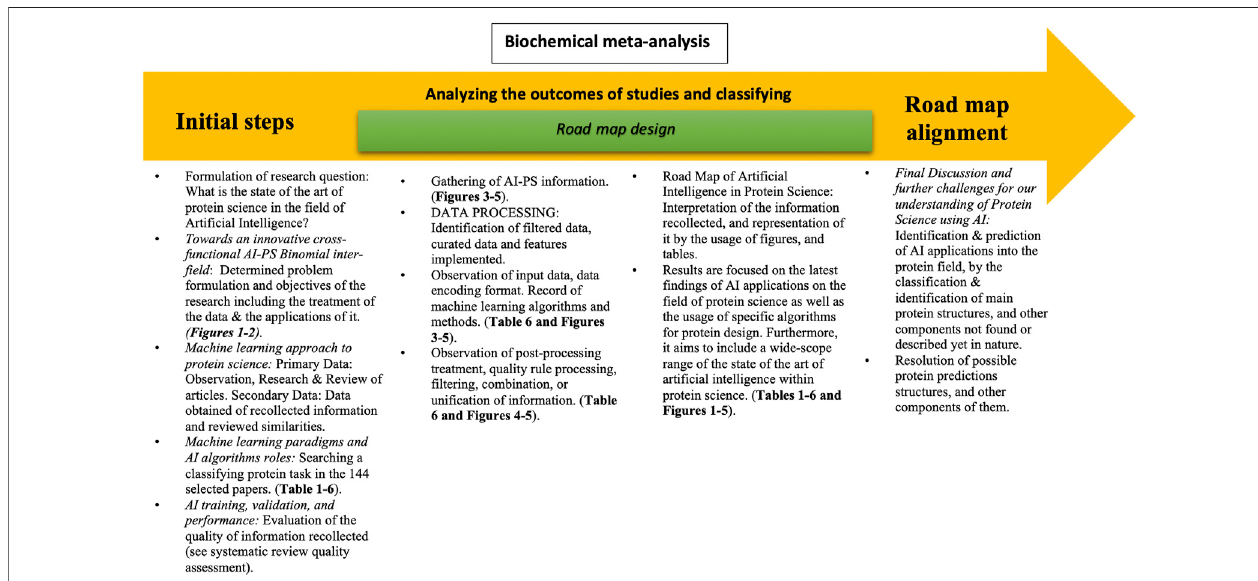
FIGURE 2 | Flowchart of article scaffold. Representation of the process throughout the entire article. The biochemical meta-analysis consists of three main steps: the systematic review, the road map design, and the road map alignment. In the systematic review, the research question is formulated in order to set the basis and objectivesoftheproject.Italsoincludestheobservationandsynthesisofinformationobtainedfromavarietyofarticlesandthecorrelationmadebetweenthem.Thelatter followed by the quality evaluation of the collected information. The road map design consists of analyzing the outcome of the studies and classifying them, thus being able to interpret the information recollected and represent it through the usage of fi gures and tables. This aims to include a wide range of the state of the art or arti fi cialintelligence.Finally,theroadmapalignmentincludesthe fi naldiscussionandfurtherchangesforourunderstandingofproteinscienceusingAIandtheresolution of possible protein science application